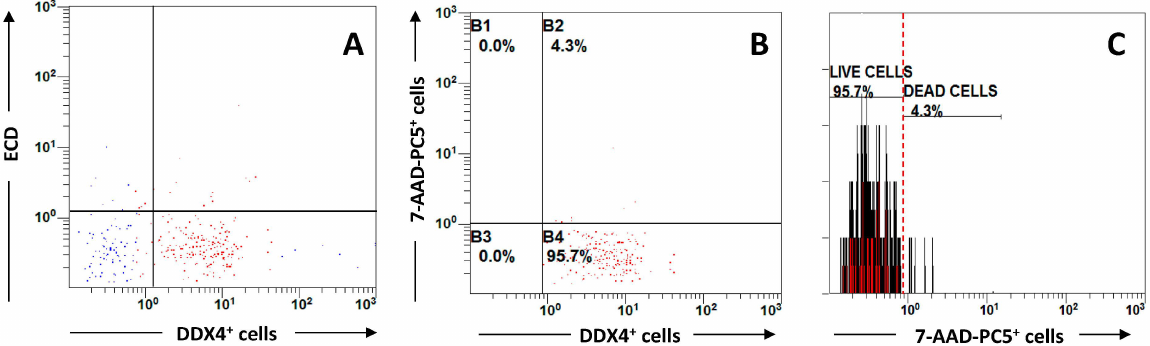
Figure 2. Flowcytometry analysis of ovarian stem cells (OSCs) isolated from a thawed ovarian cortex sample. After isolating the cell suspension by Ficoll density gradient, the cell population incubated with FITC-conjugated anti-Ddx4 oogonial marker included a large consistency of positive cells ( A ), which were then analyzed in their vitality using the PC5-conjugated 7-AAD viability marker. As shown, almost the full population, namely 95.7% of Ddx4-positiive cells were found viable in contrast with a minority equal to 4.3% of dead cells ( B , C ). This result suggested that the cryopreservation of ovarian cortex fragments in liquid nitrogen is almost indolent on the OSC viability and that probably other functions including their capability to differentiate in oocytes in vitro is also restored after their thawing. (Values are percentage of positive cells measured on 10,000 events).